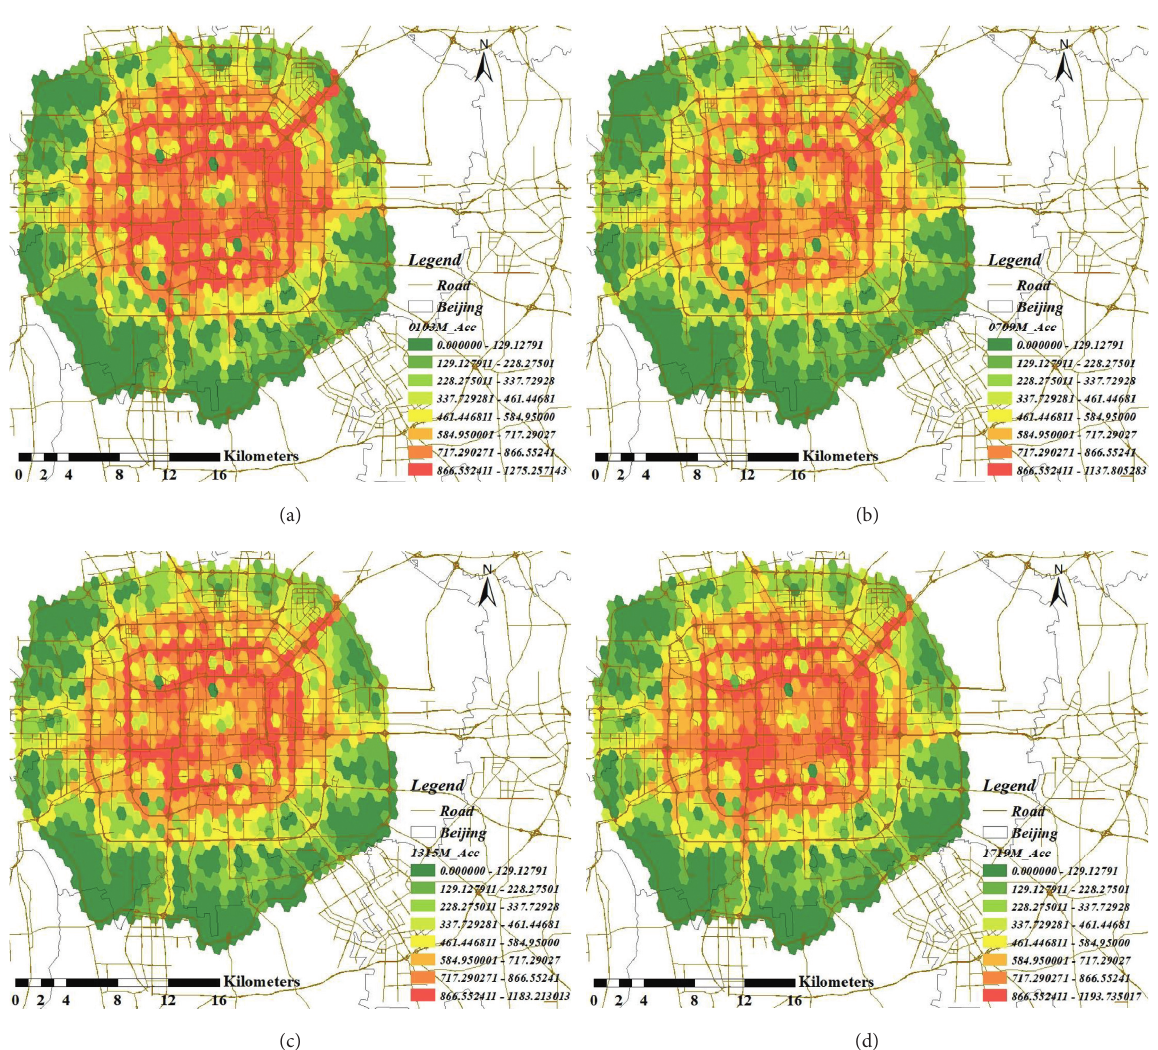
Figure 9: Healthcare accessibility at different time intervals: (a) 1:00–3:00. (b) 7:00–9:00. (c) 13:00–15:00. (d)